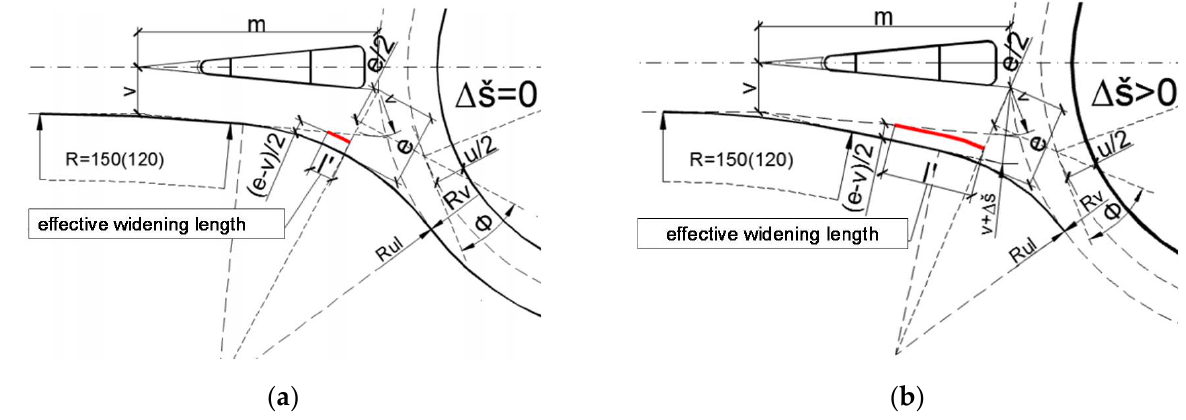
Figure 19. Entry design according to [4]: ( a ) shorter effective widening length and ( b ) longer effective widening length; “v” is the approach lane width, “m” is the splitter island length, “R v ” is the roundabout outer radius, and “R ul ” is the entry radius.